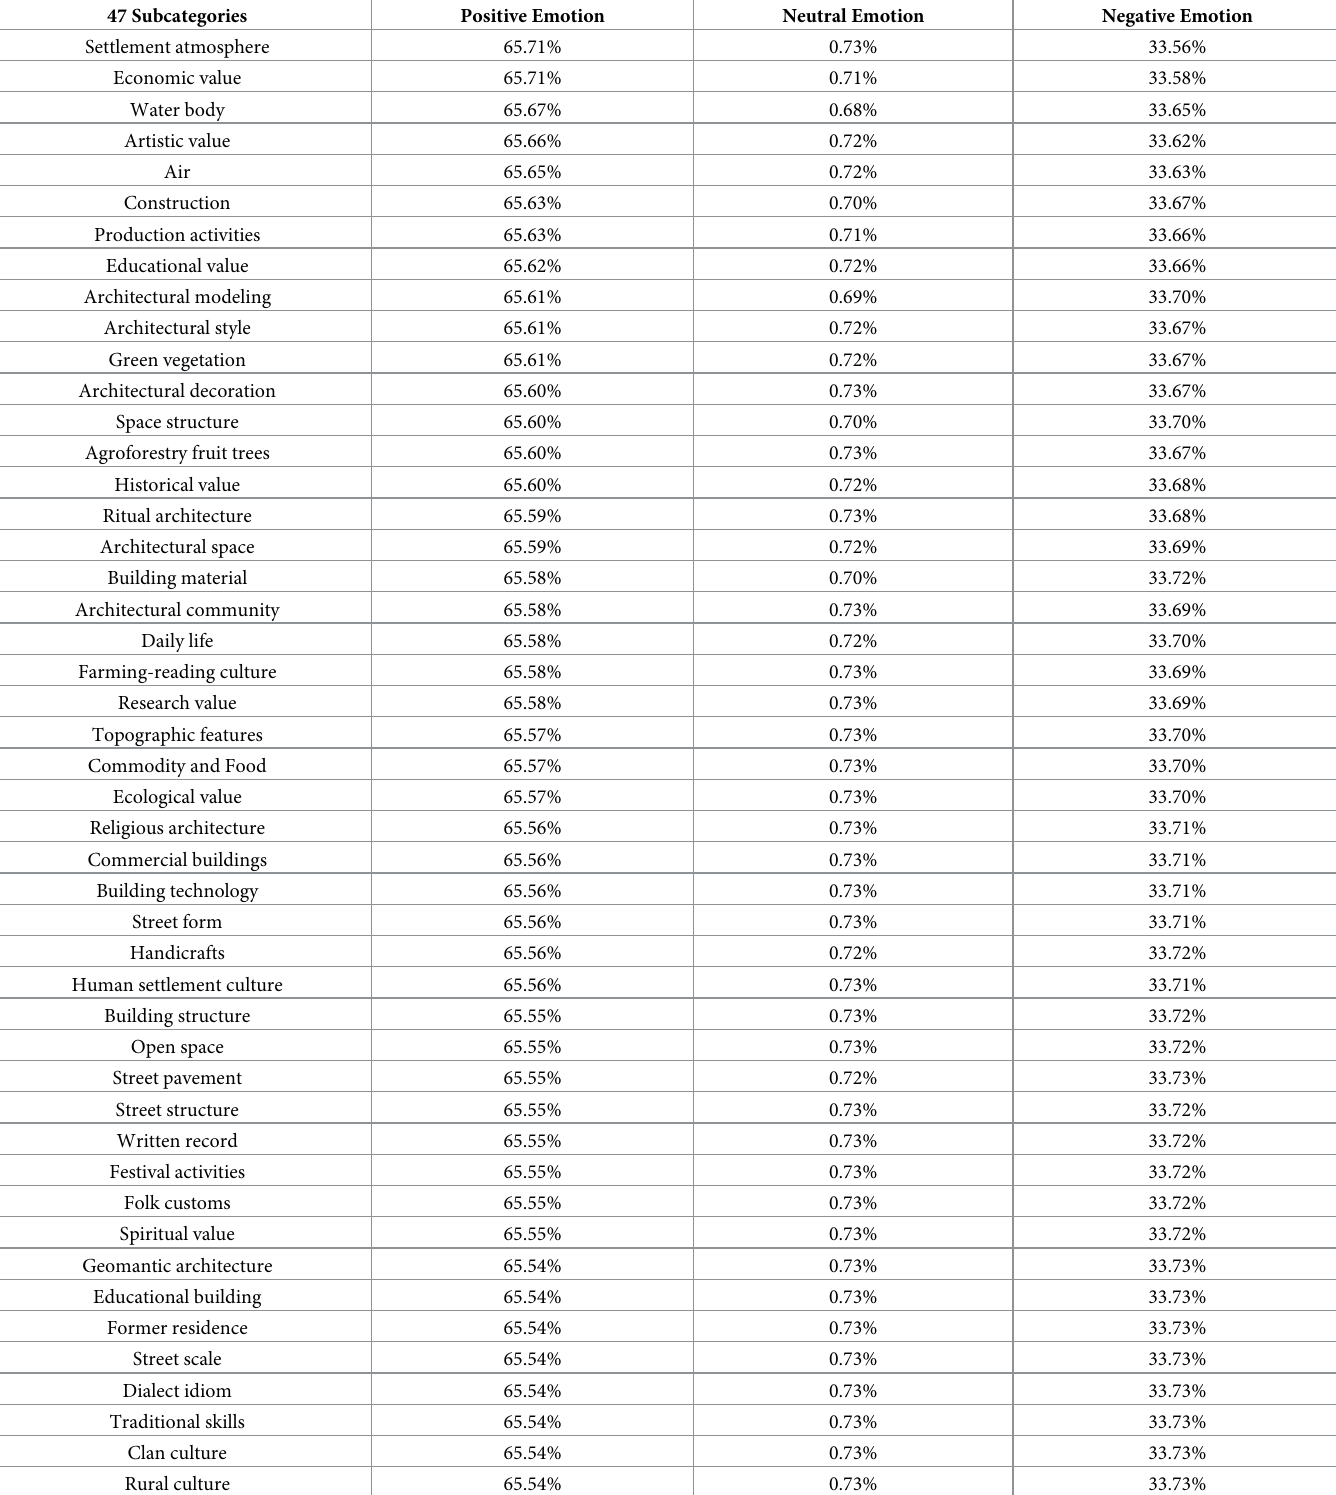
Table 6. The emotional tendencies of 47 perceptual subcategories of traditional settlement cultural